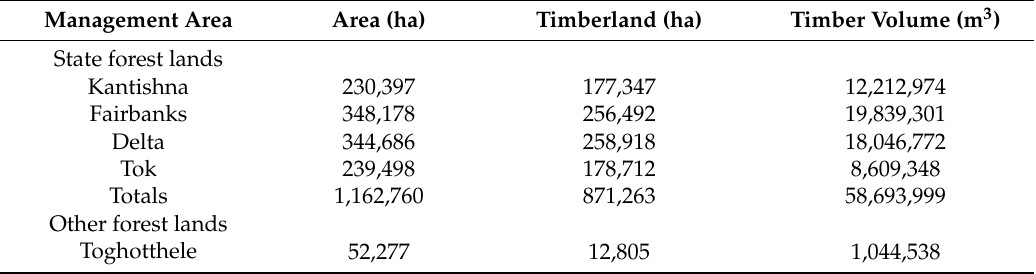
Table 1. Area of the land, timberland, and volume of wood on state and other forest lands [26]. Data was only available for Toghotthele Native Corporation lands for other forest